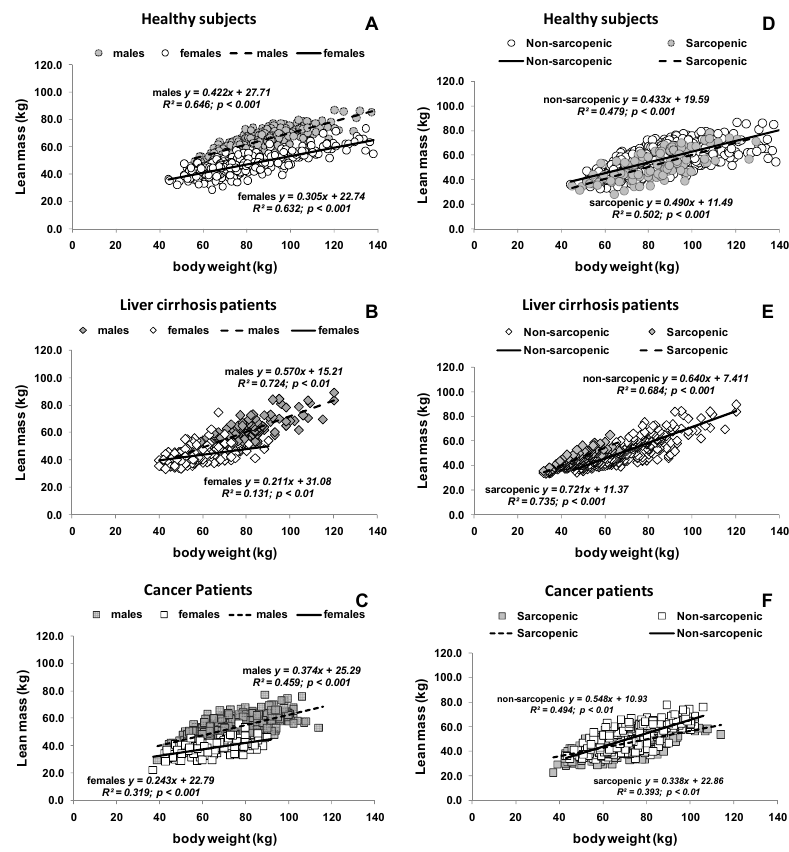
Figure 1. Relationship between lean mass and body weight in healthy subjects, patients with liver cirrhosis and cancer. The relationship is presented stratified by: sex ( A – C ); and sarcopenic phenotype ( D – F ). Lean mass was measured as LST by DXA or CT in healthy subjects and cancer patients and FFM by BIA in cirrhotic patients (solid line and broken line show the corresponding regression line).